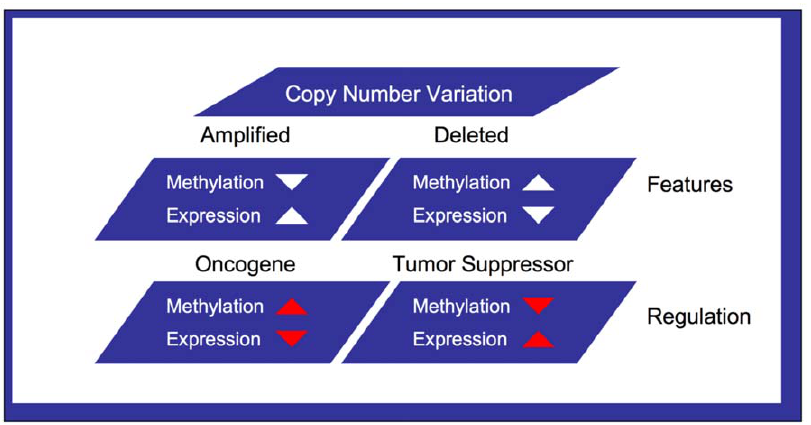
Figure 1. Genomic and epigenetic features of tumor suppressors and oncogenes. Copy number variation is the base genomic feature for our identification of tumor suppressor and oncogenic gene properties in ovarian cancer. An oncogene can be overexpressed under amplified copy number and low methylation, while hypermethylation can be used for regulating expression in a gene amplified state. Similarly, decreased tumor suppressor expression can be the result of partial copy number loss with hypermethylation. Tumor suppressors may also possibly be regulated via hypomethylation in a copy number deleted stated. Our analysis is modeled for such properties and first examines the CNV per gene and then attributes epigenetic alteration for each copy number aberration with gene expression.